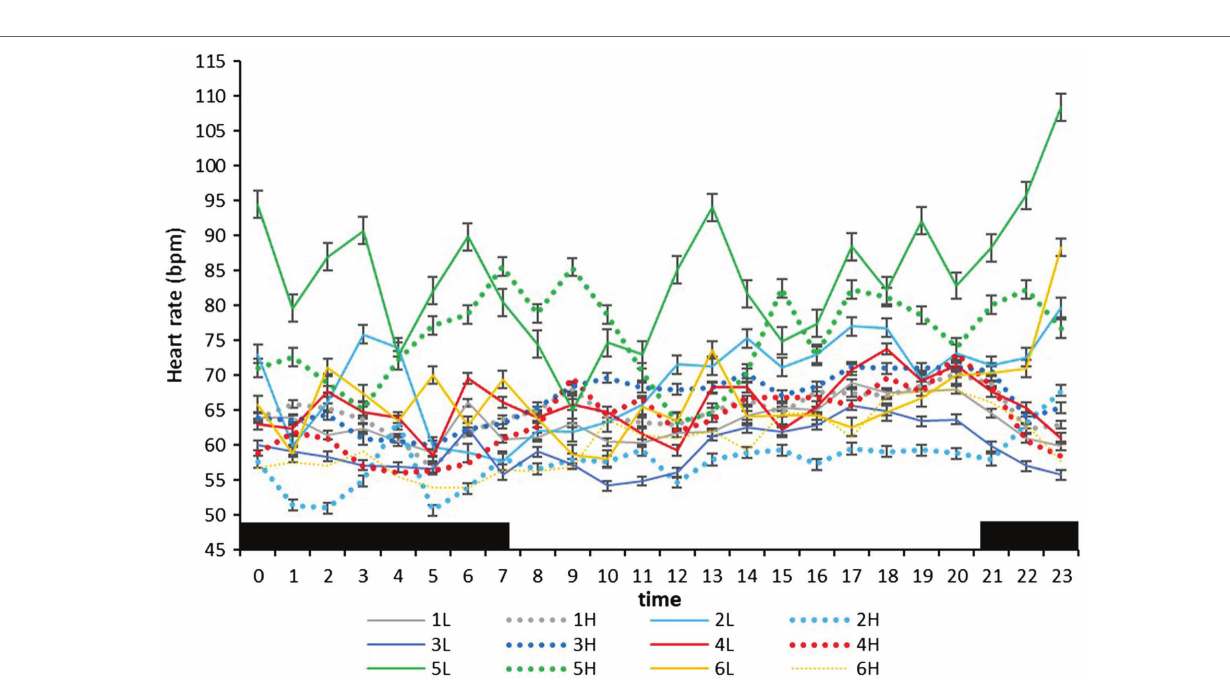
FIGURE 3 | Mean (±SEM) heart rate (bpm) of six cows measured by subcutaneous bio-loggers on 5 days of grazing at 1.5 LSUs/ha (low density, L) followed by 5 days of grazing at a density of 128 LSUs/ha (high density, H). Black areas indicate night (22:00–06:00